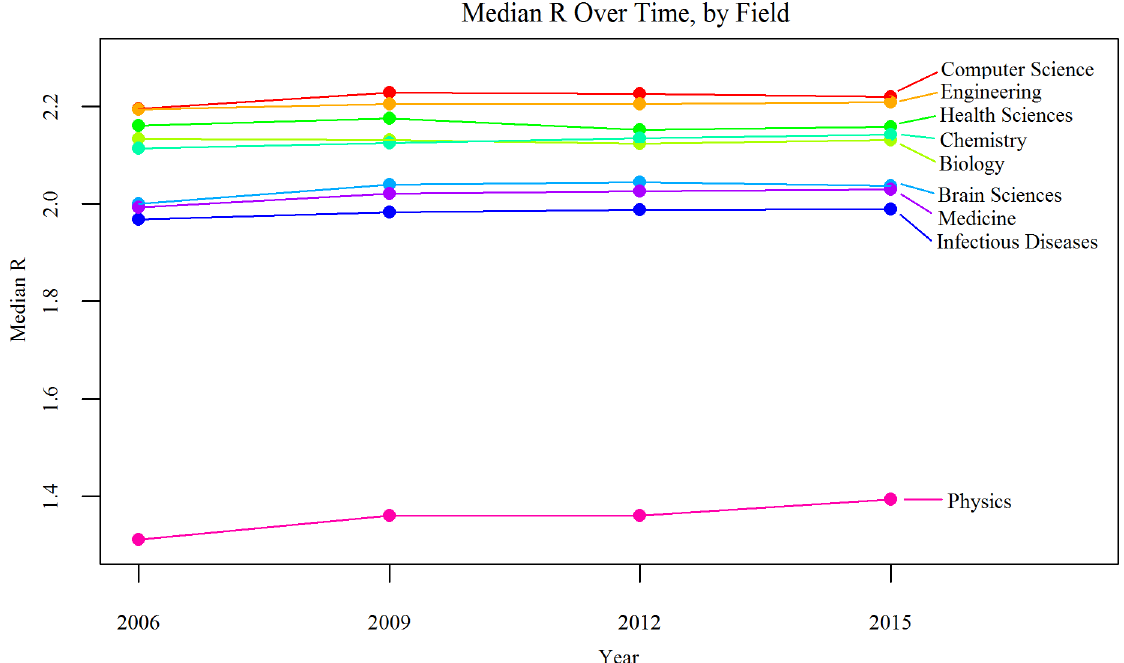
Fig 2. Median R value over time for each field, for the set of 9,314 researchers with 30 or more publications and an I 1 of 4 or more by the end of 2006. Data is shown for fields with 100 or more